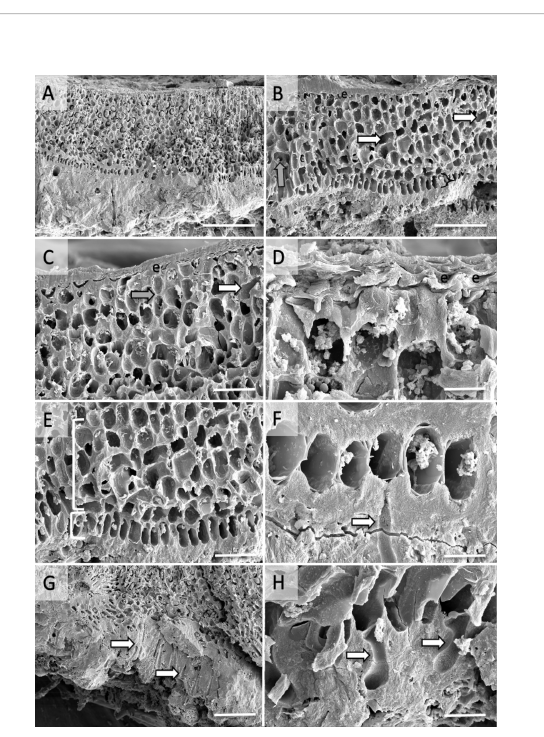
FIGURE 4 Scanning Electron Microscopy images of Ramicrusta hawaiiensis voucher LAF7678. (A) Section view of thallus construction, scale bar = 200 µm. (B) Section showing cell fusions (arrows), epithallial cells (e), and hypobasal cells (bracket), scale bar = 100 µm. (C) Section showing epithallial cells (e), primary pit connections (gray arrow), and cell fusions (white arrows), scale bar = 50 µm. (D) Zoomed in view of layered epithallial construction (e), scale bar = 10 µm. (E) Section showing perithallial cells with cell fusions (top bracket) and a single row of hypobasal cells (bottom bracket), scale bar = 50 µm. (F) Enlarged view of single row of hypobasal cells with rhizoid (arrow), scale bar = 20 µm. (G) Section showing multiple rhizoids, common (arrows), scale bar = 100 µm. (H) Zoomed in view of rhizoids (arrows), scale bar = 20